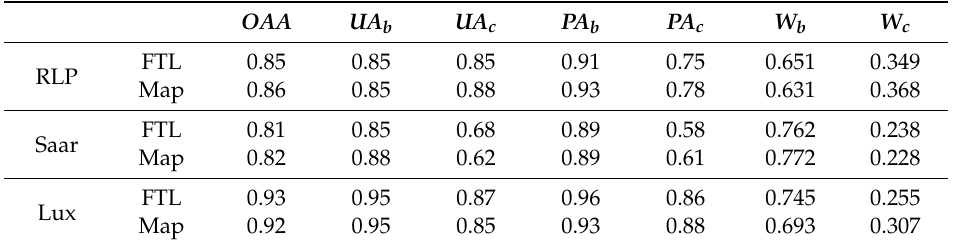
Table 13. Validation of the HR-FTL and the mapping approach (Updated map based on the NDVI) reporting the OAA, user’s (UA) and producer’s accuracy (PA) for mapped broadleaved (subscript b ) and coniferous forest (subscript c ) in the three subregions.